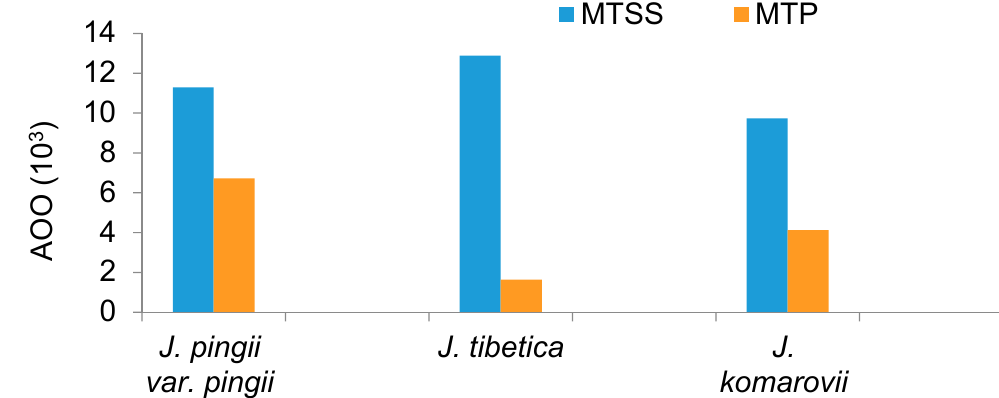
Figure 3. Potential present AOO of the three target Juniperus species derived from ensemble modelling based on two thresholds: maximum training sensitivity plus specificity (MTSS) and minimum training presence (MTP).